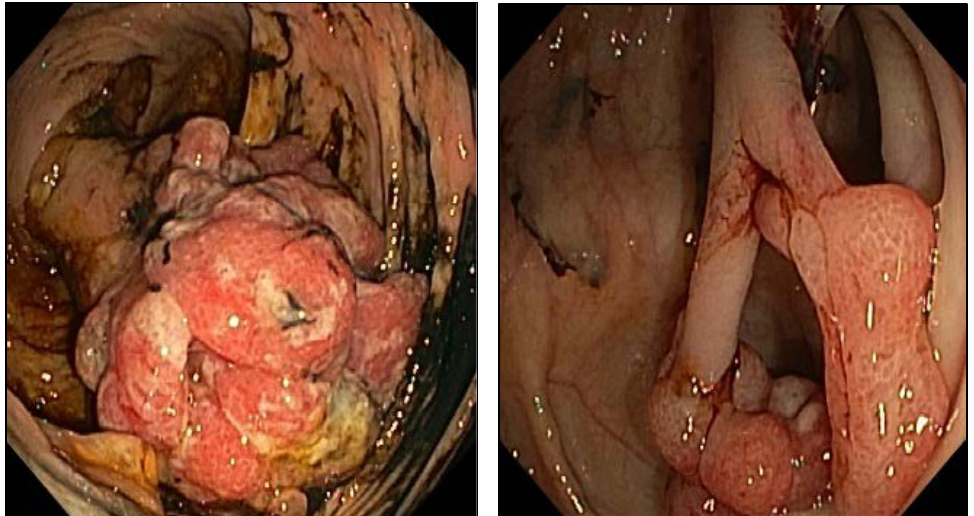
Figure 2. Colonoscopy of III:6 showing a giant cecal polyp (left) and a bifid sigmoid polyp (right). At histology, lesions were confirmed to be “juvenile polyps”. Dysplastic foci were found in the giant neoformation.